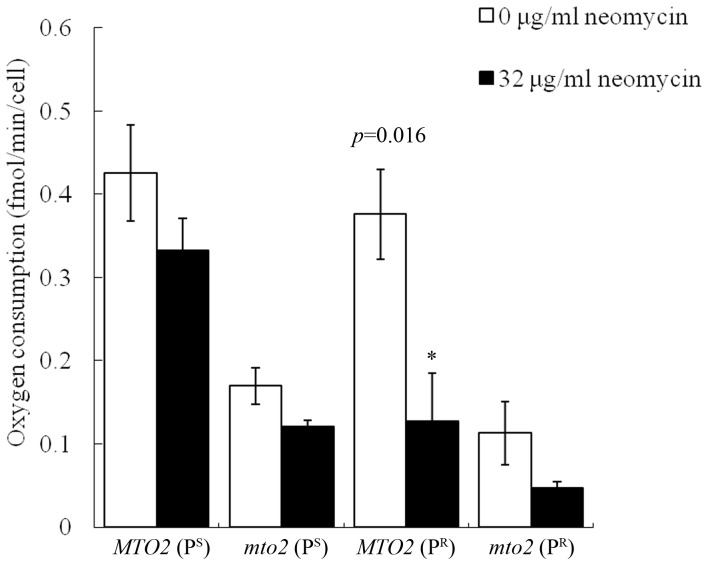
Assay of Oxygen consumption rates.Cells were harvested in the mid log-phase. The oxygen consumption rate of each yeast strain was measured at the density of 4×105 cells/well by FX-96 oxygraph (SeaHorse Biosciences) in the absence or presence of 32 μg/ml neomycin. The results are shown as means±SD of triplicate.